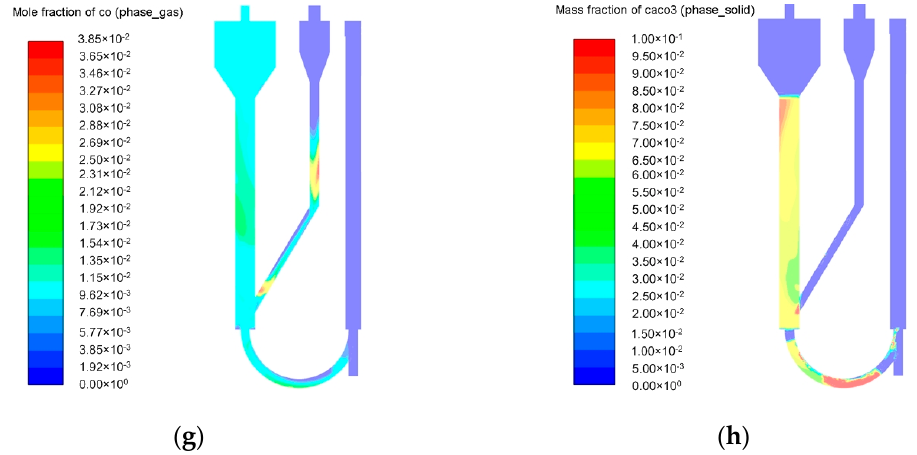
Figure 5. ( a ) Solid-phase volume fraction. ( b ) Static pressure distribution. ( c ) CH 4 mole-fraction distribution. ( d ) H 2 O mole-fraction distribution. ( e ) H 2 mole-fraction distribution. ( f ) CO 2 mole-fraction distribution. ( g ) CO mole-fraction distribution ( h ) CaCO 3 mole-fraction distribution.